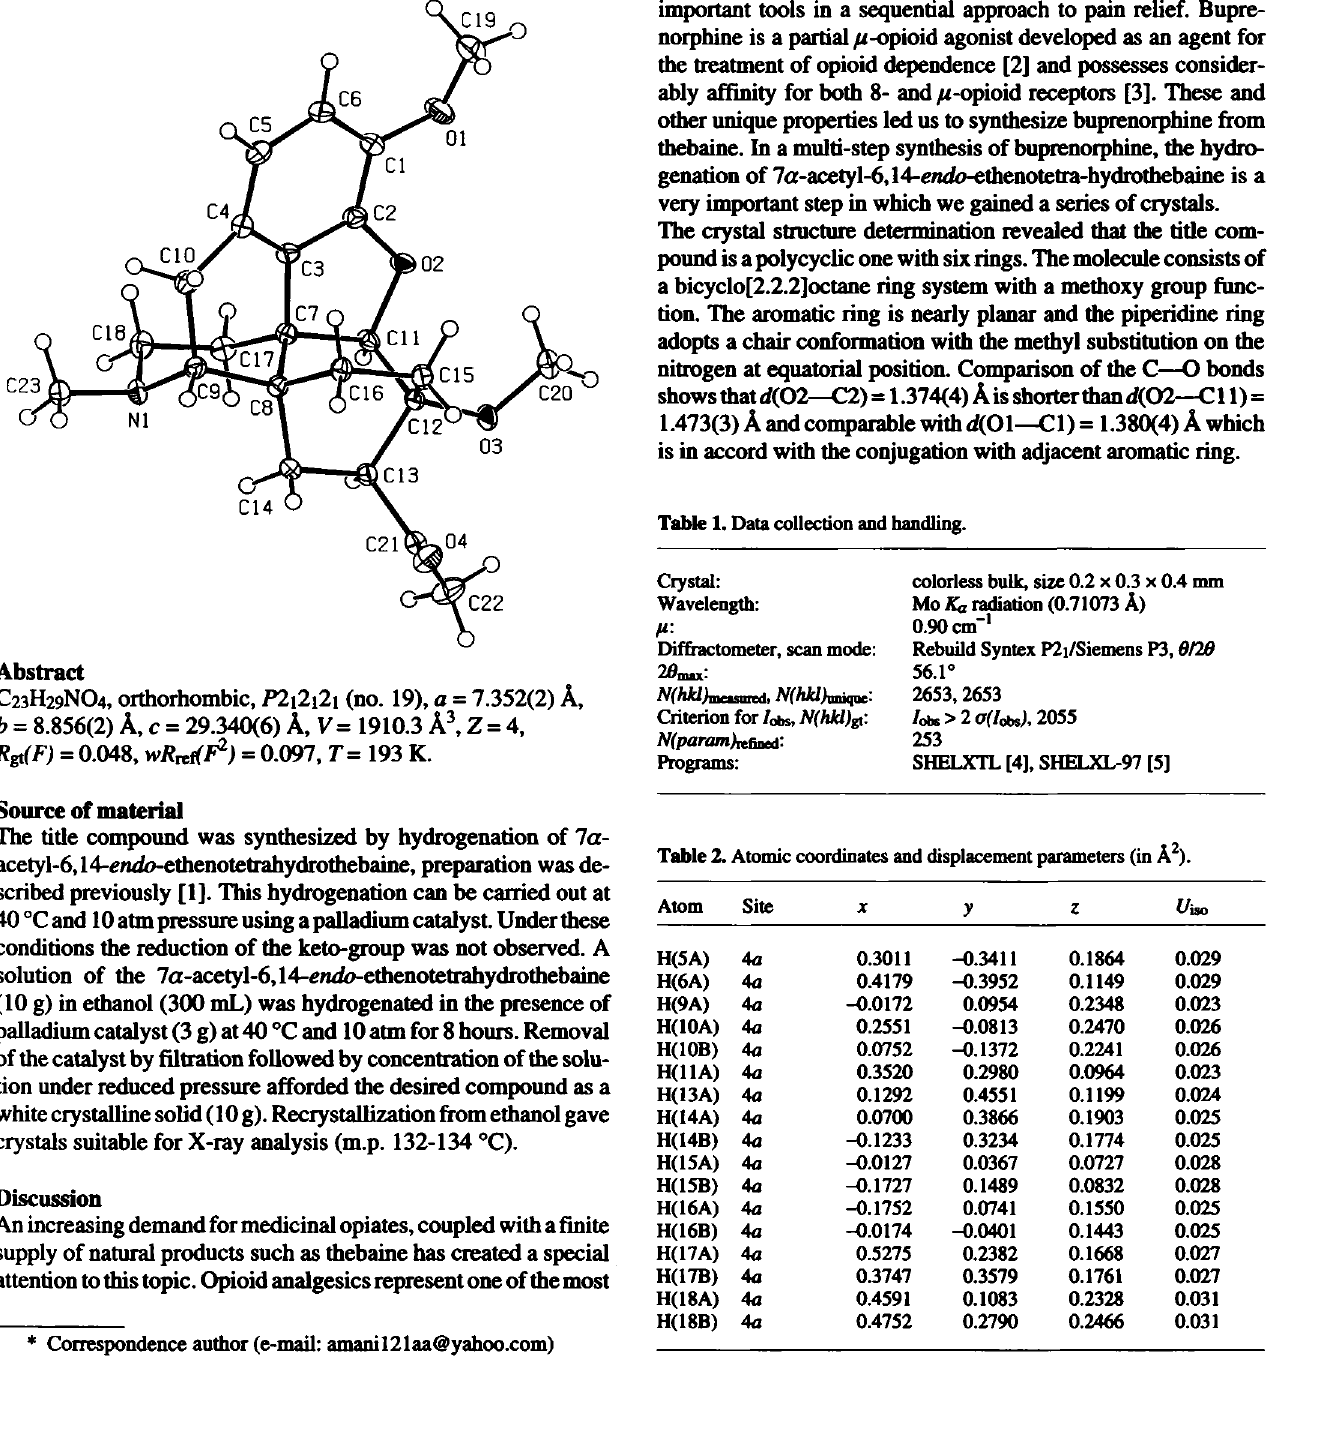
Table 1. Data collection and handling.